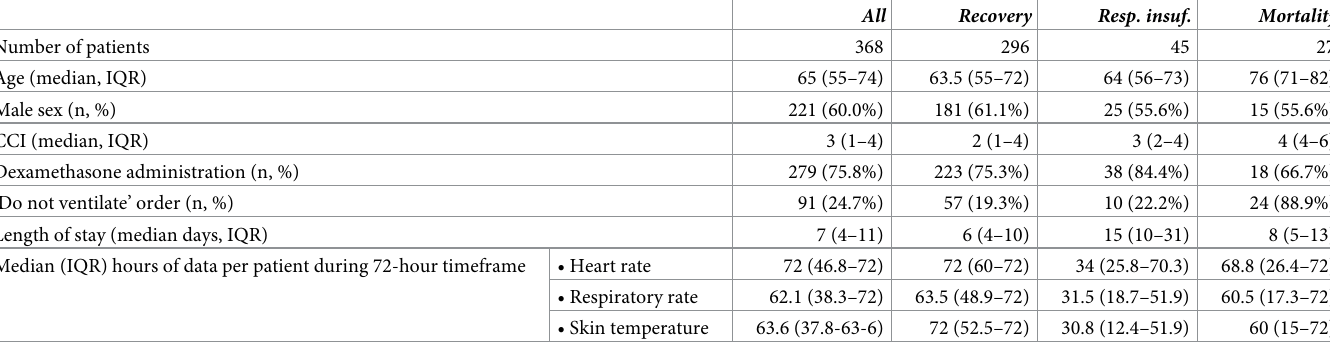
Table 1. Patient characteristics and median duration of recorded vital signs during three-day observation period.